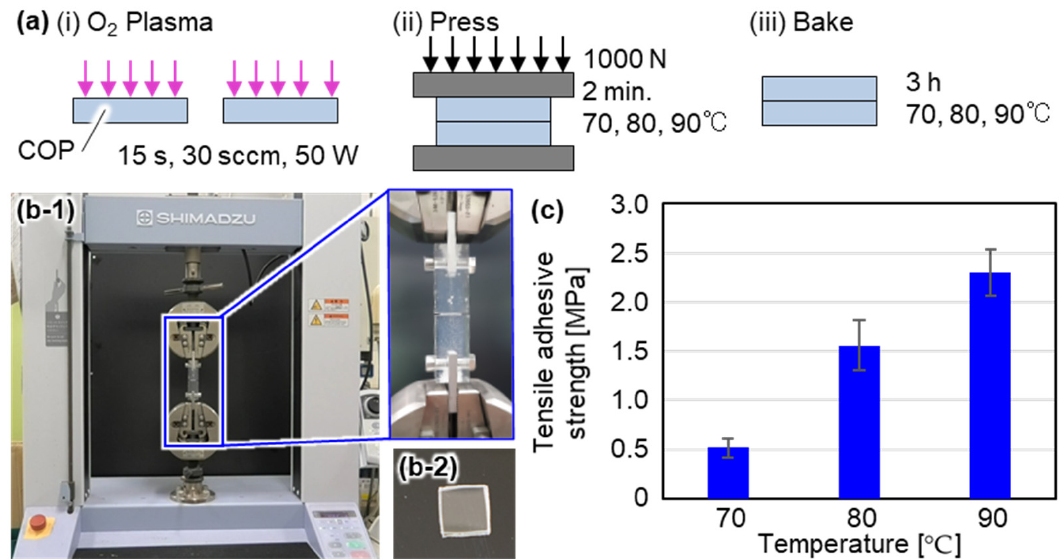
Figure 2. Bonding of COP-COP layers. ( a ) COP-COP bonding procedure, ( b-1 ) Photographs of the tensile test device, ( b-2 ) Photographs of the COP plate used in the evaluation of the tensile adhesive strength, and ( c ) Evaluation of the tensile adhesive strength.